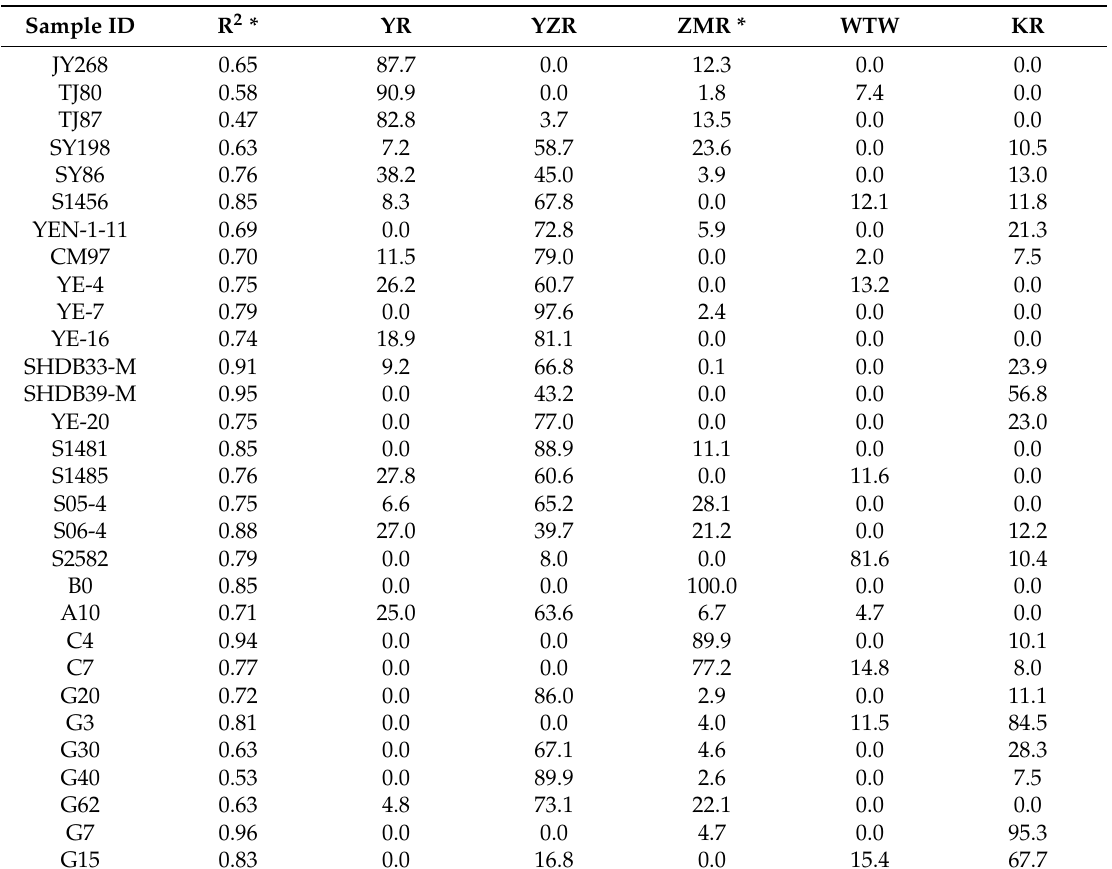
Table 2. Mixing coe ffi cients of five important river sources in the east China